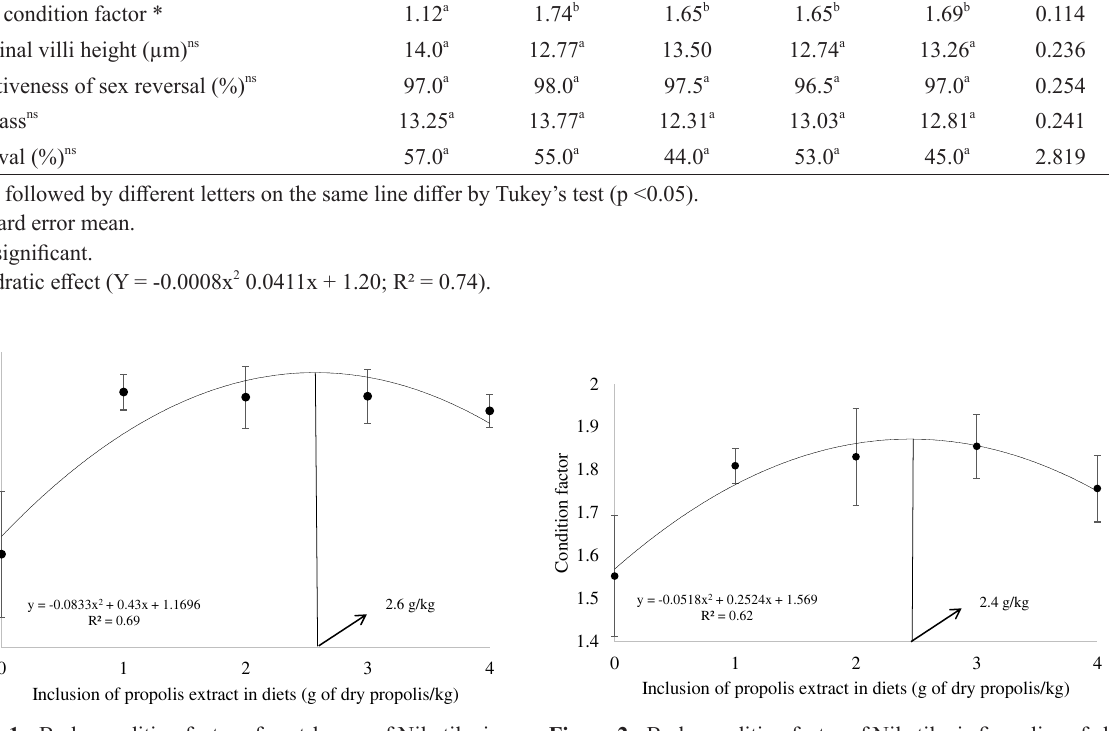
Figure 2 - Body condition factor of Nile tilapia fingerlings fed Figure 2. Body condition factor of Nile tilapia fingerlings fed with increasing levels of alcoholic 15 with increasing levels of alcoholic extract of extract of propolis. 16